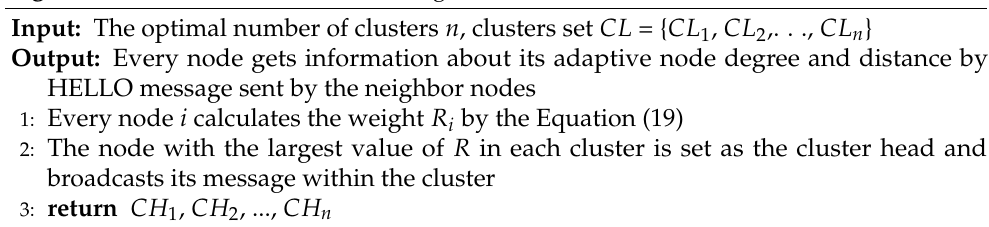
Algorithm 2 Cluster Head Selection